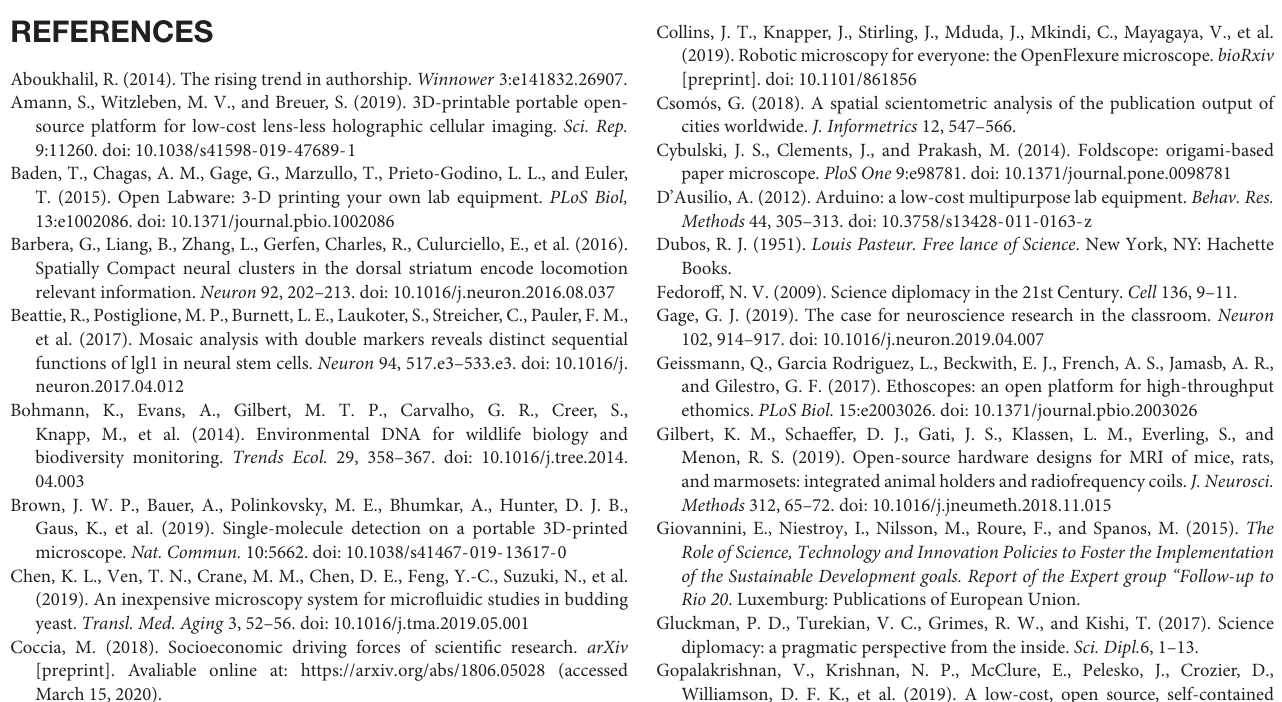
Figure 1 provided by https://pixabay.com/users/mcmurryjulie- 2375405/, image of mobile devices was adapted from an image by https://pixabay.com/users/nick_h-1821910/ and image of a polar bear was from https://pixabay.com/photos/ polar-bear-zoo-white-bear-animal-1959068/. We